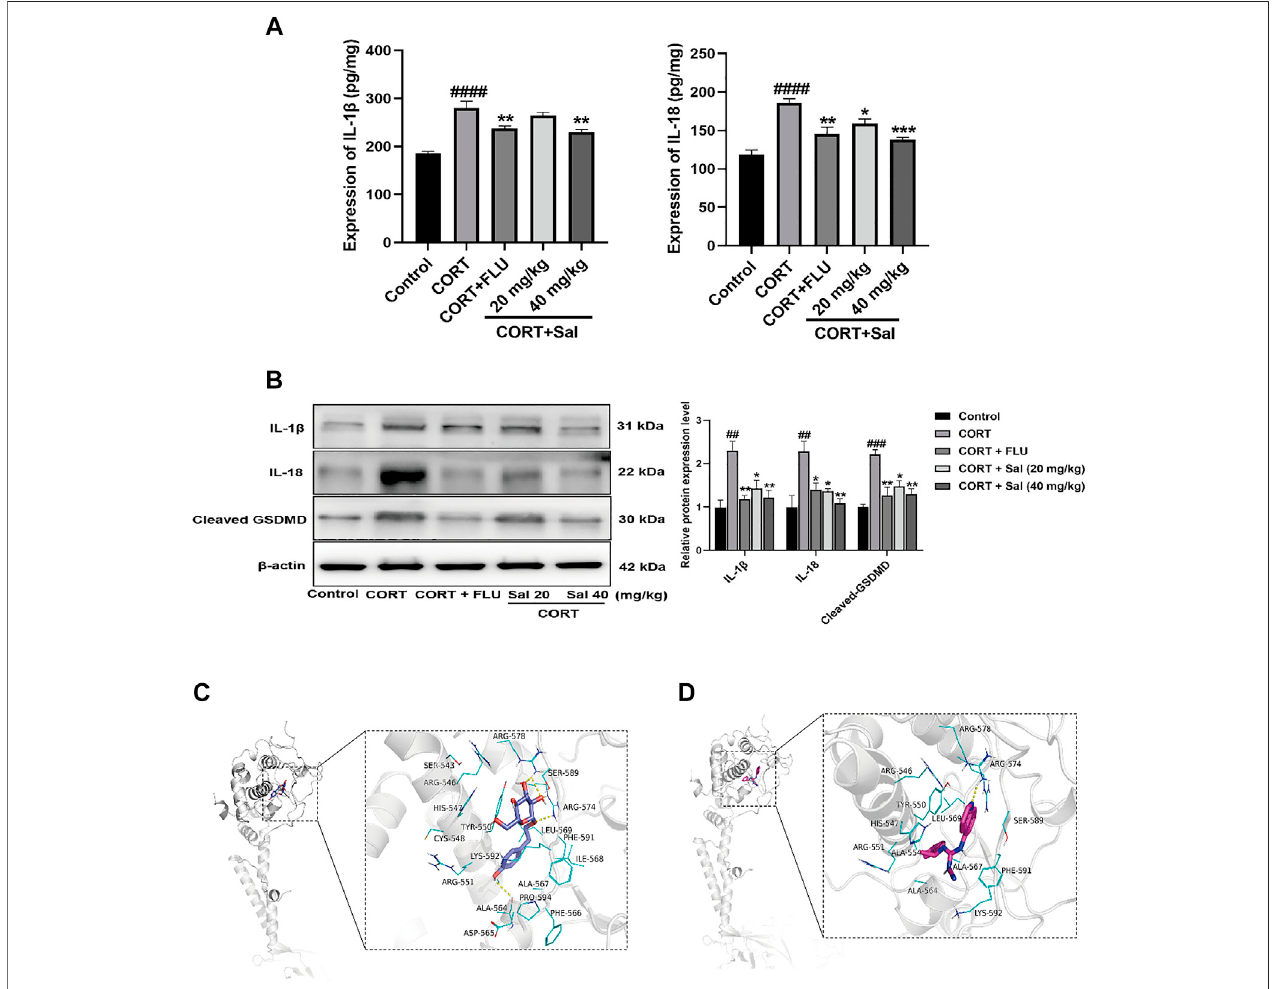
FIGURE2| SalmitigatespyroptosisinCORT-induceddepressioninmice. (A) ThelevelsofIL-1 β andIL-18inthehippocampusweredetectedbyELISAassay( n = 5). (B) The measurement of cleaved GSDMD, IL-1 β and IL-18 in the hippocampus was detected by Western blot ( n = 3). (C) Structural interactions of Sal with P2X7. 3D diagram of interaction between Sal and P2X7 showed the major binding sites and bonding forces. (D) Structural interactions of A-804598 (a P2X7R antagonist) with P2X7.3DdiagramofinteractionbetweenP2X7andA-804598showedthemajorbindingsitesandbondingforces.TheStructuraloverview(left)andthecloseview (right). Dotted lines (yellow) represent hydrogen bonding interactions. #### p < 0.0001, ## p < 0.01 versus the control group; *** p < 0.001, ** p < 0.01, * p < 0.05 versus the CORT